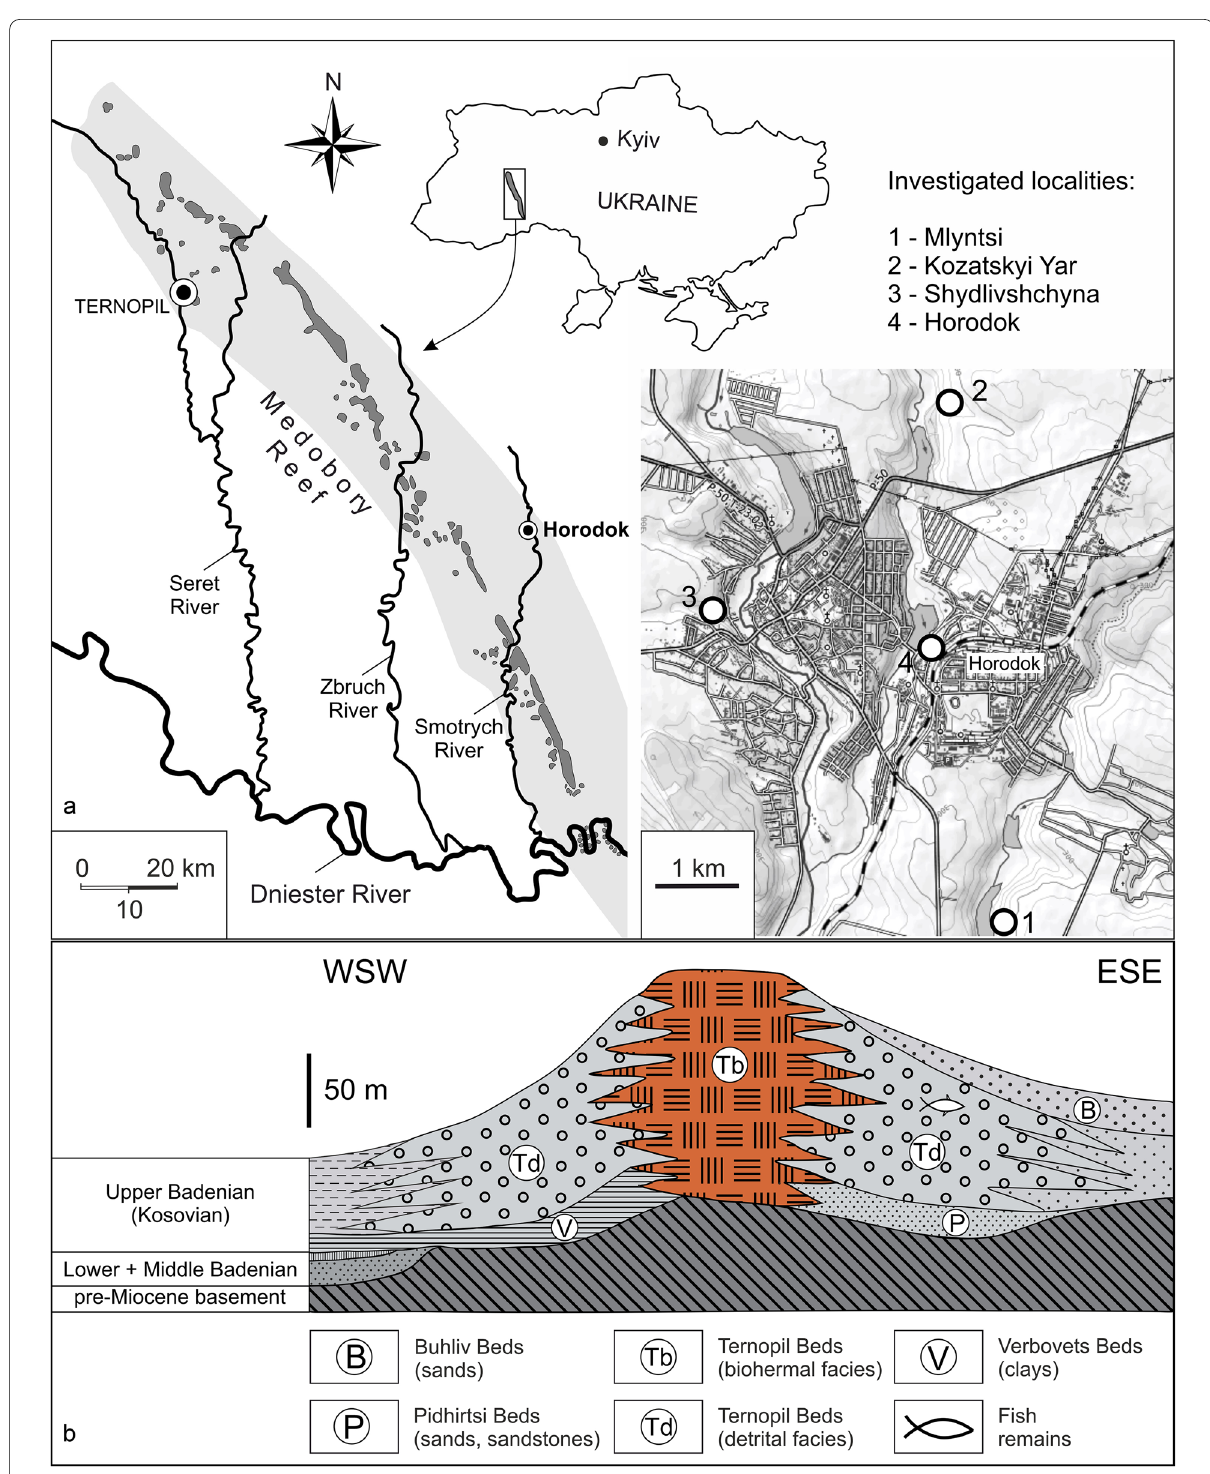
Fig. 1 Location map and stratigraphy: a schematic map showing the Medobory Reef (after Korolyuk, 1952, and Górka et al., 2012, with modifications) and the studied localities in the vicinities of Horodok, western Ukraine; b schematic geologic cross section of the Badenian sequence through the Medobory region after Wysocka et. al. (2016) and Górka